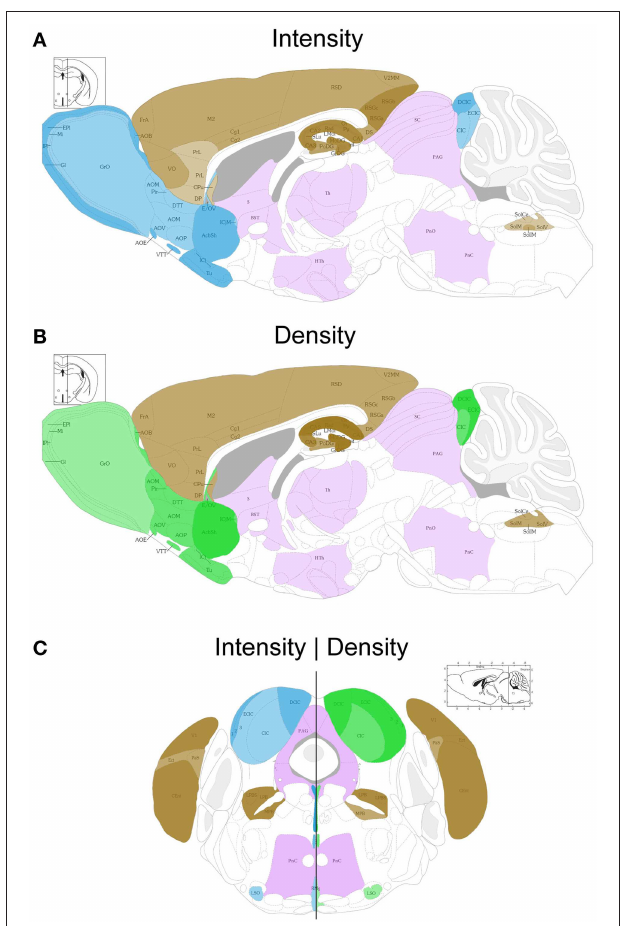
FIGURE 2 | Schematic sagittal (A,B) and coronal (C) overviews showing the mean UBB + 1 intensity (blue) (A,C left) and density (green) (B,C right) in a wide range of mouse brain nuclei. Regions previously reported to be UBB + 1 immunoreactive (cerebral cortex, hippocampus, dentate gyrus, amygdala, striatum, nucleus parabrachialis, and Sol) are shown in brown. The UBB + 1 intensity and density in OB, Acb, IC and the raphe nuclei are shown in blue and green, respectively. Different gradations of brown, blue, and green are used indicating the level of staining intensity or density with a light gradation for a low intensity or density, a medium gradation for a moderate intensity or density level, a dark gradation for a high intensity or density level and a very dark gradation for a very high intensity or density. Other sizeable regions with a low to moderate UBB + 1 -immunoreactivity are shown in purple. However, more regions are positive for UBB + 1 , for details see Tables 2 and S2. Figures are adapted from the mouse brain atlas of Franklin and Paxinos figure 106 and 73, respectively (Franklin and Paxinos, 2007). BST, bed nucleus of the stria terminalis; Gi, gigantocellular reticular nucleus; HTh, hypothalamus; PAG, periaqueductal gray; PnC, pontine reticular nucleus, caudal part; PnO, pontine reticular nucleus, oral part; S, septal area; SC, superior colliculus; Th,